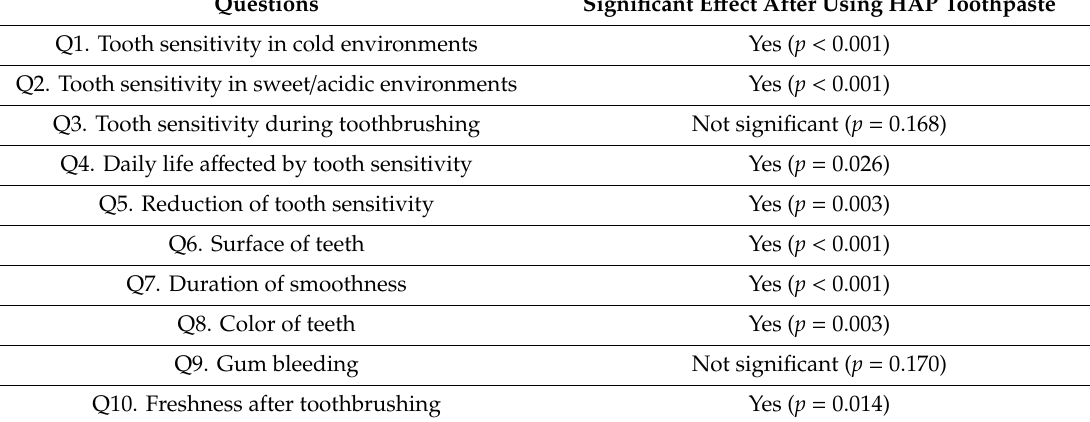
Table 3. Significance tests between baseline and follow-up (after 4-week use of the HAP toothpaste); p -values of the t -test for paired samples for pre-post-changes. The non-parametric Wilcoxon tests confirm the results of the t -tests for paired